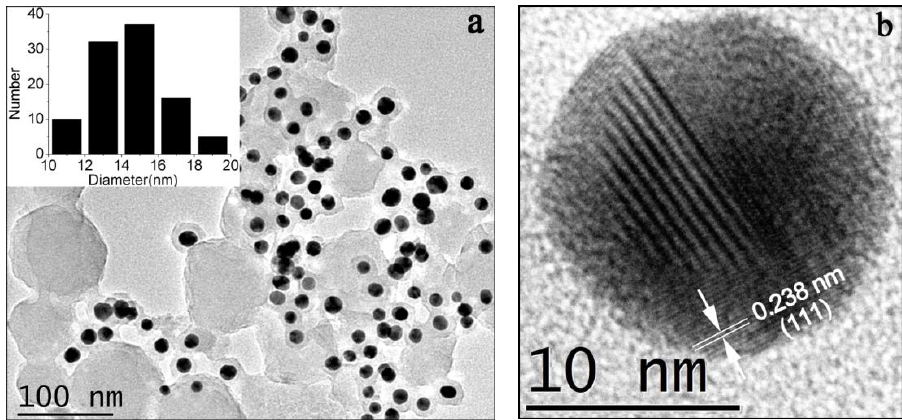
Figure 4. ( a ) The representative TEM images of proanthocyanidin-functionalized gold nanoparticles; ( b ) HRTEM images of one typical gold nanoparticle.